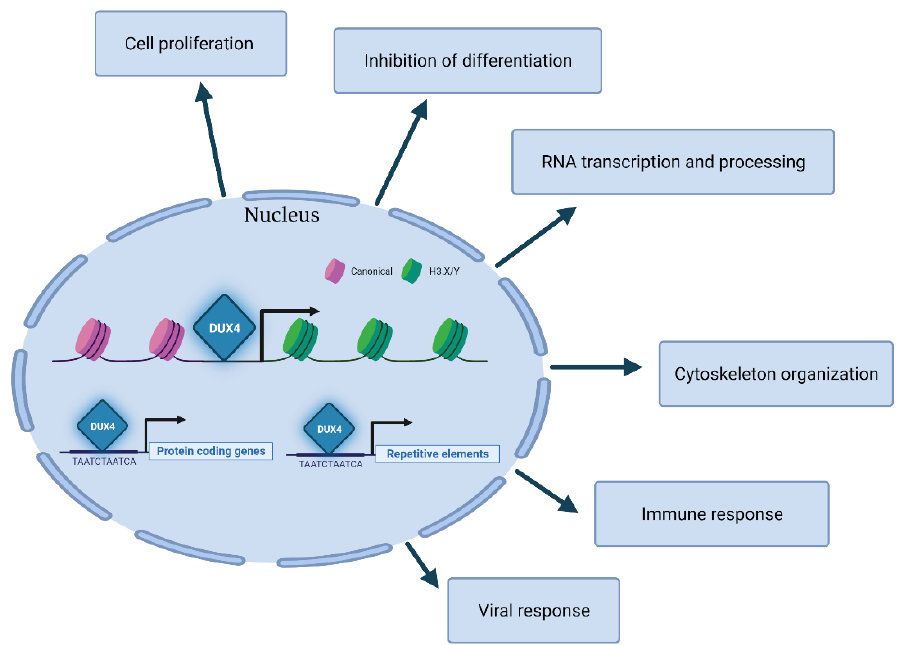
Figure 3. DUX4 transcriptional pathways. Main pathways modulated by DUX4 across different studies highlight several processes, including proliferation, inhibition of cell differentiation, RNA transcription and processing, cytoskeleton organization, immune response and viral response.